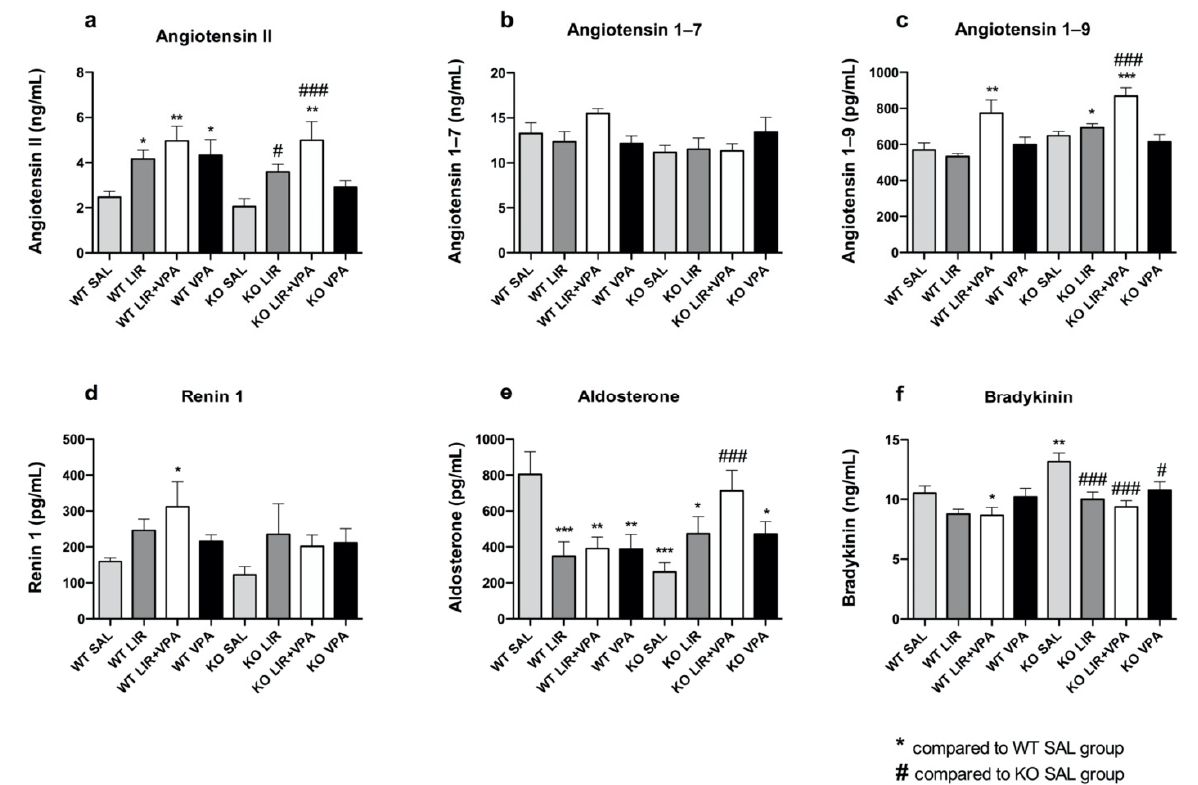
Figure 5. Wfs1 deficiency leads to drastic decrease in aldosterone and increase in bradykinin serum levels. Neurohormone levels were measured from the blood serum of 3.5–4-month-old animals after 8 days of treatment with liraglutide (LIR), valproate (VPA), liraglutide + valproate (LIR + VPA), or saline (SAL). ELISA was used to measure the serum level of ( a ) angiotensin II, ( b ) angiotensin 1–7, ( c ) angiotensin 1–9, ( d ) renin 1, ( e ) aldosterone and ( f ) bradykinin. Data were compared using factorial ANOVA, followed by Fisher’s LSD tests; * p < 0.05; ** p < 0.01; *** p < 0.001 compared to WT vehicle (SAL) group and # p < 0.05; ### p < 0.001 compared to KO vehicle (SAL) group. The data are presented as the mean ± SEM, n = 7–8 per group.